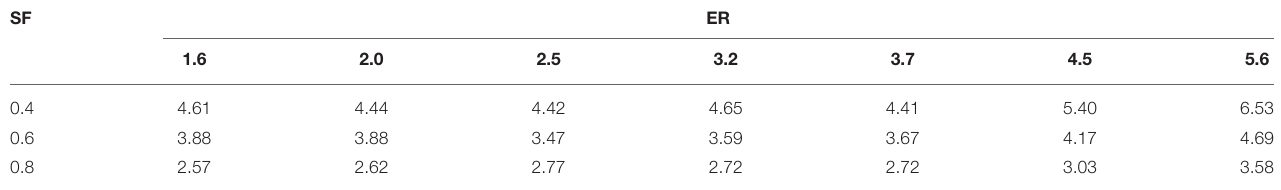
TABLE 6 | TEIR is the energy recovery ratio between oxygen-steam and air-steam gasification.